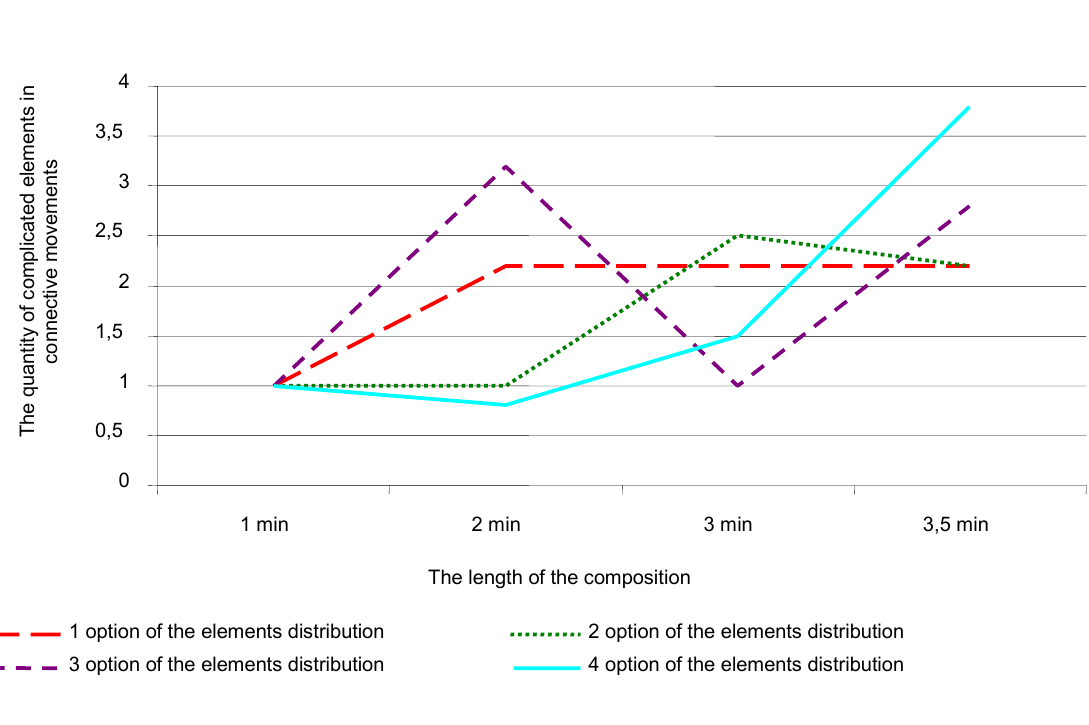
Picture 1. Options of the complicated elements distribution by the minutes of the free routine composition